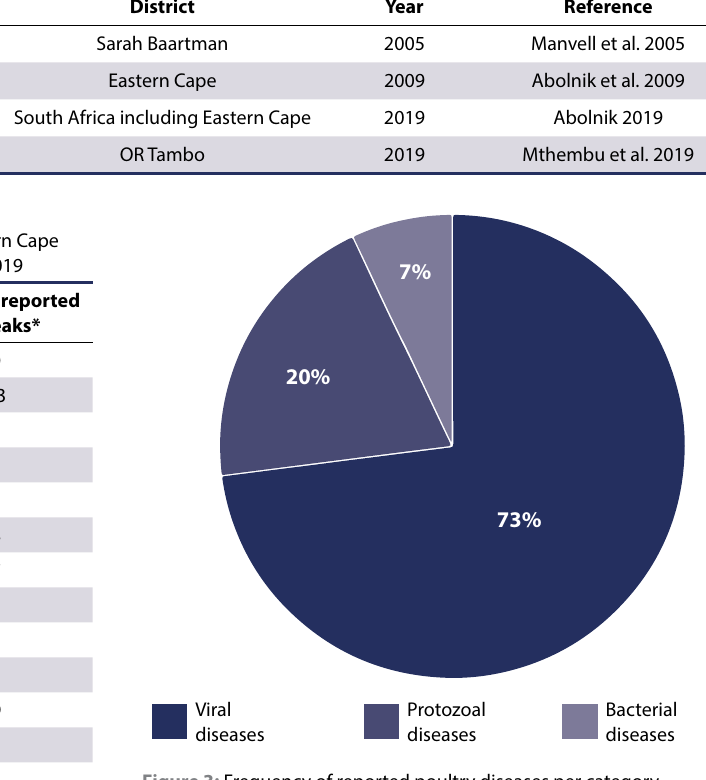
Figure 3: Frequency of reported poultry diseases per category